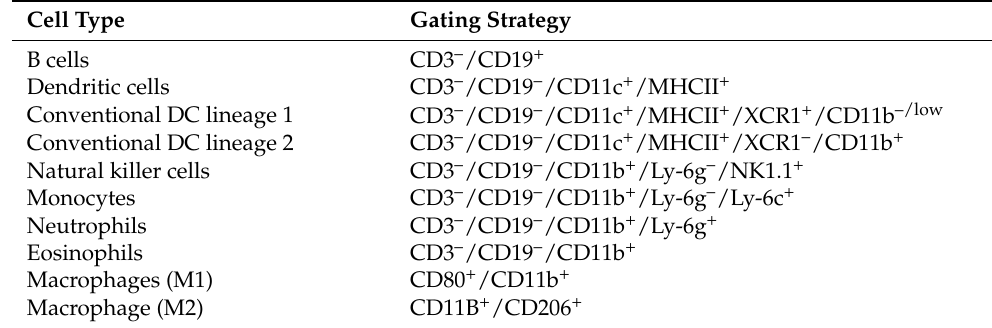
Table 1. Cell populations were defined based on the following